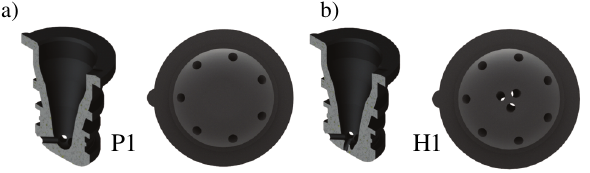
Fig. 1. Prechambers cross-section and a bottom-side image: a) P1, b) H1 Due to the location of the outflow channels and the re-